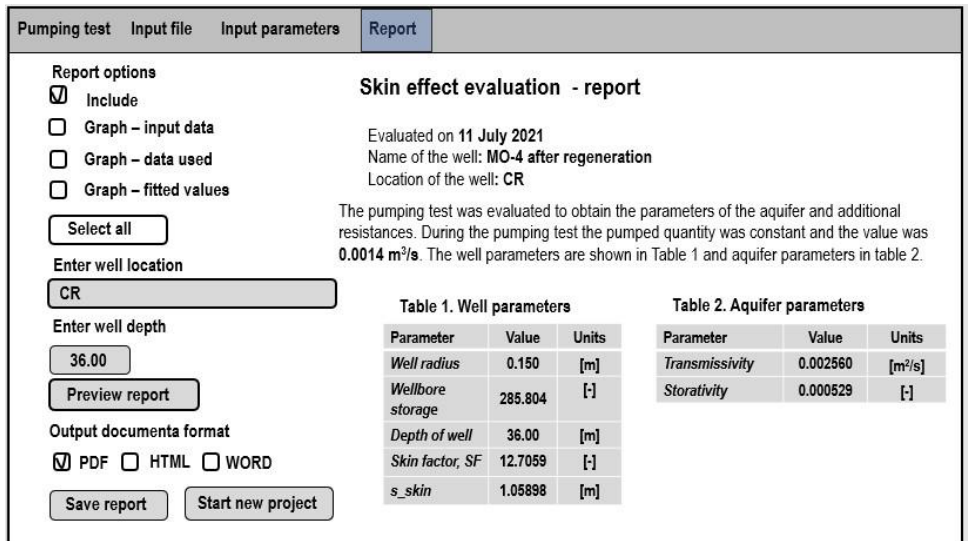
Figure 13. Final report for well MO-4 after rehabilitation.